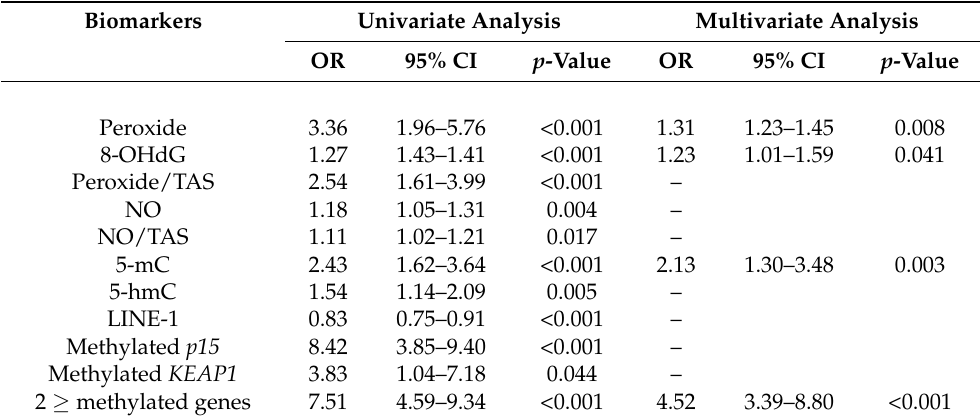
Table 4. Univariate and multivariate logistic regression analysis in patients with myelodysplastic